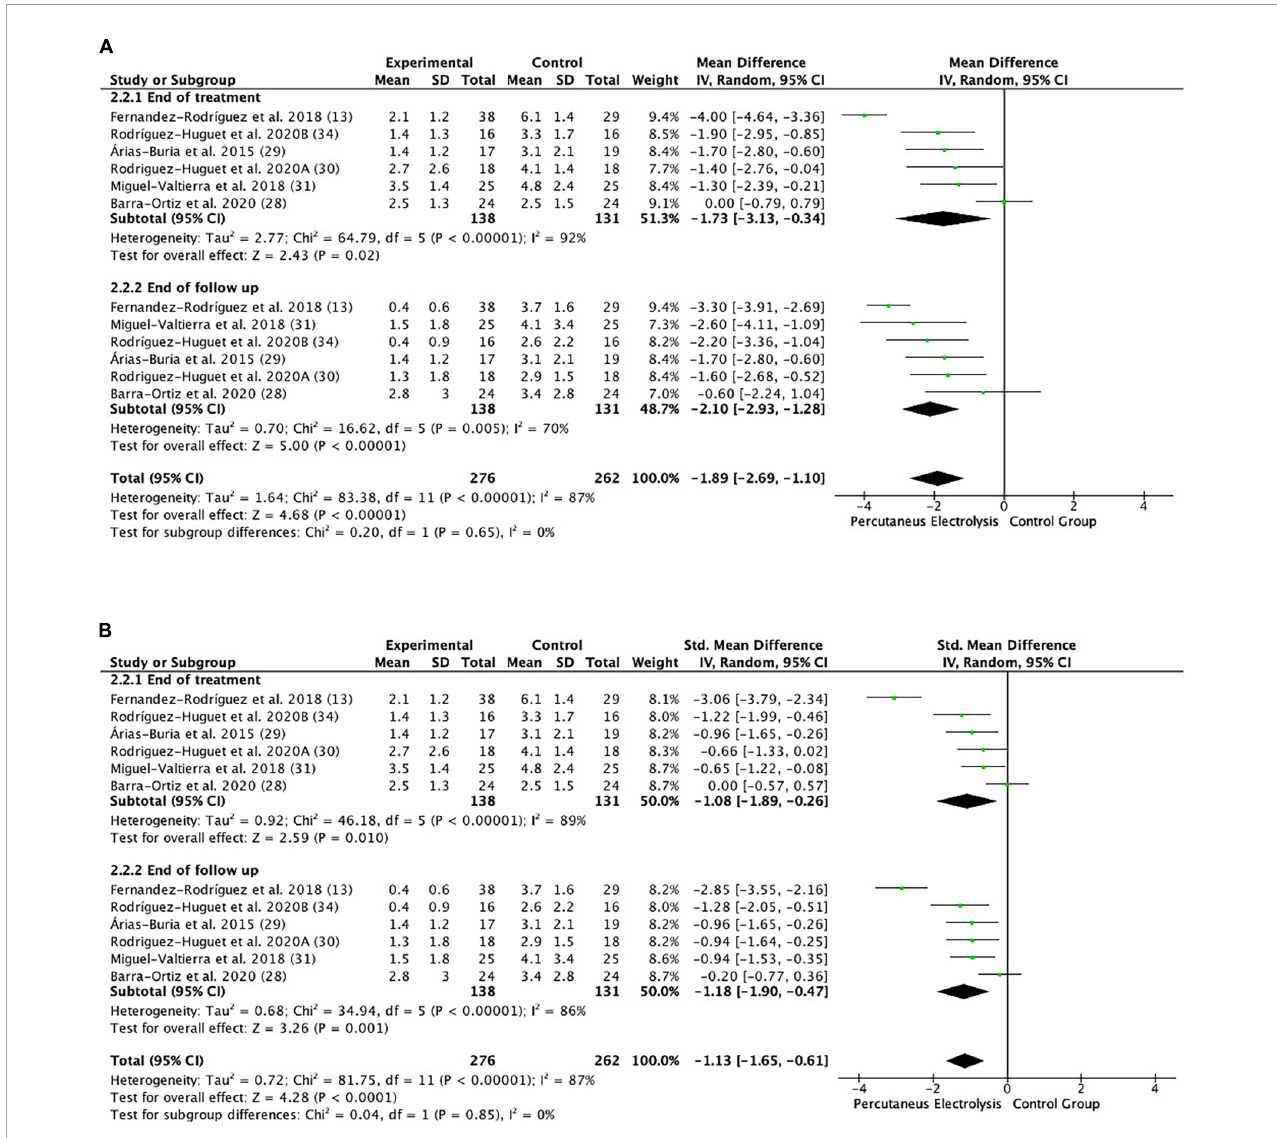
FIGURE3 Forest plot of the results of a random-effects meta-analysis shown as (A) mean differences (MD) and (B) SMD, with 95% confidence interval (CI) for the comparison of mean pain in the low intensity PE group and the control group. Short-term and long-term subgroups are reflected, depending on the time of the pain assessment. The shaded square represents the point estimate for each individual study and the weight of the study in the meta-analysis. The diamond represents the overall mean difference of the studies.